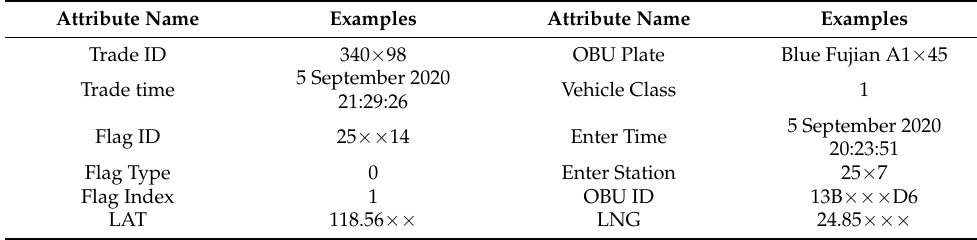
Table 2. ETC gantry system transaction data